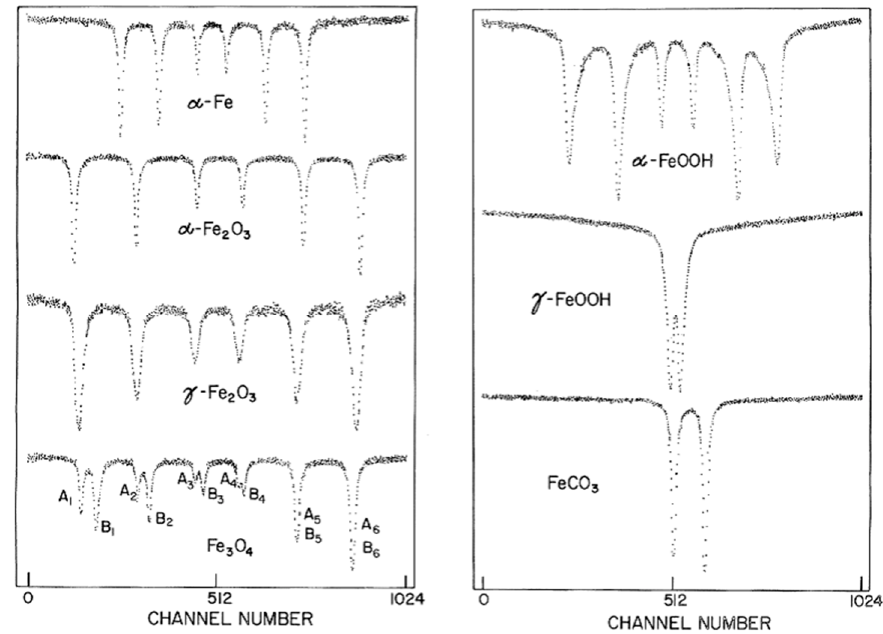
Figure 14. Room temperature Mössbauer spectra of α -Fe and of main corrosion products of ferrous alloys. Reproduced from [37], with permission from NACE International-Corrosion Society, 1976.